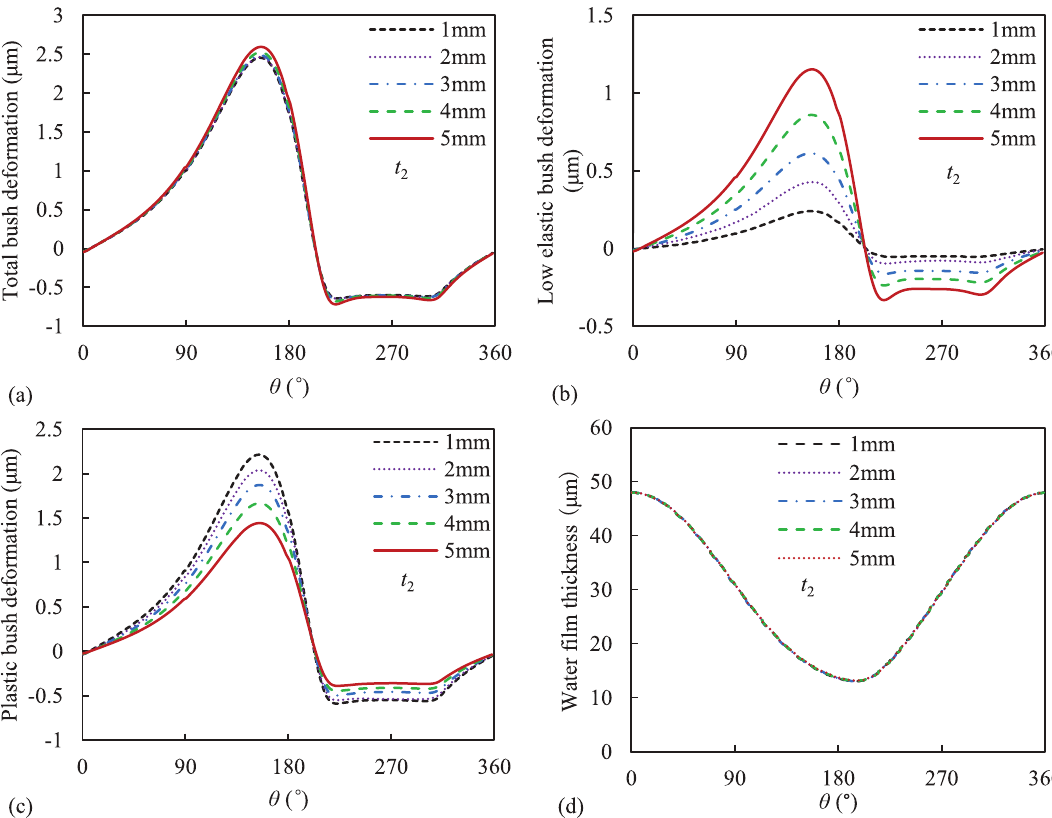
Fig. 14. (a) Bush total deformation distribution, (b) Deformation distribution of low elastic under-layer bush, (c) Deformation distribution of plastic layer bush, (d) Water fi lm thickness distribution for different low elastic under-layer bush thickness ( e =0.6, N =1500 rpm, E 1 = 1000MPa, E 2 =400 MPa, n 1 =0.4, n 2